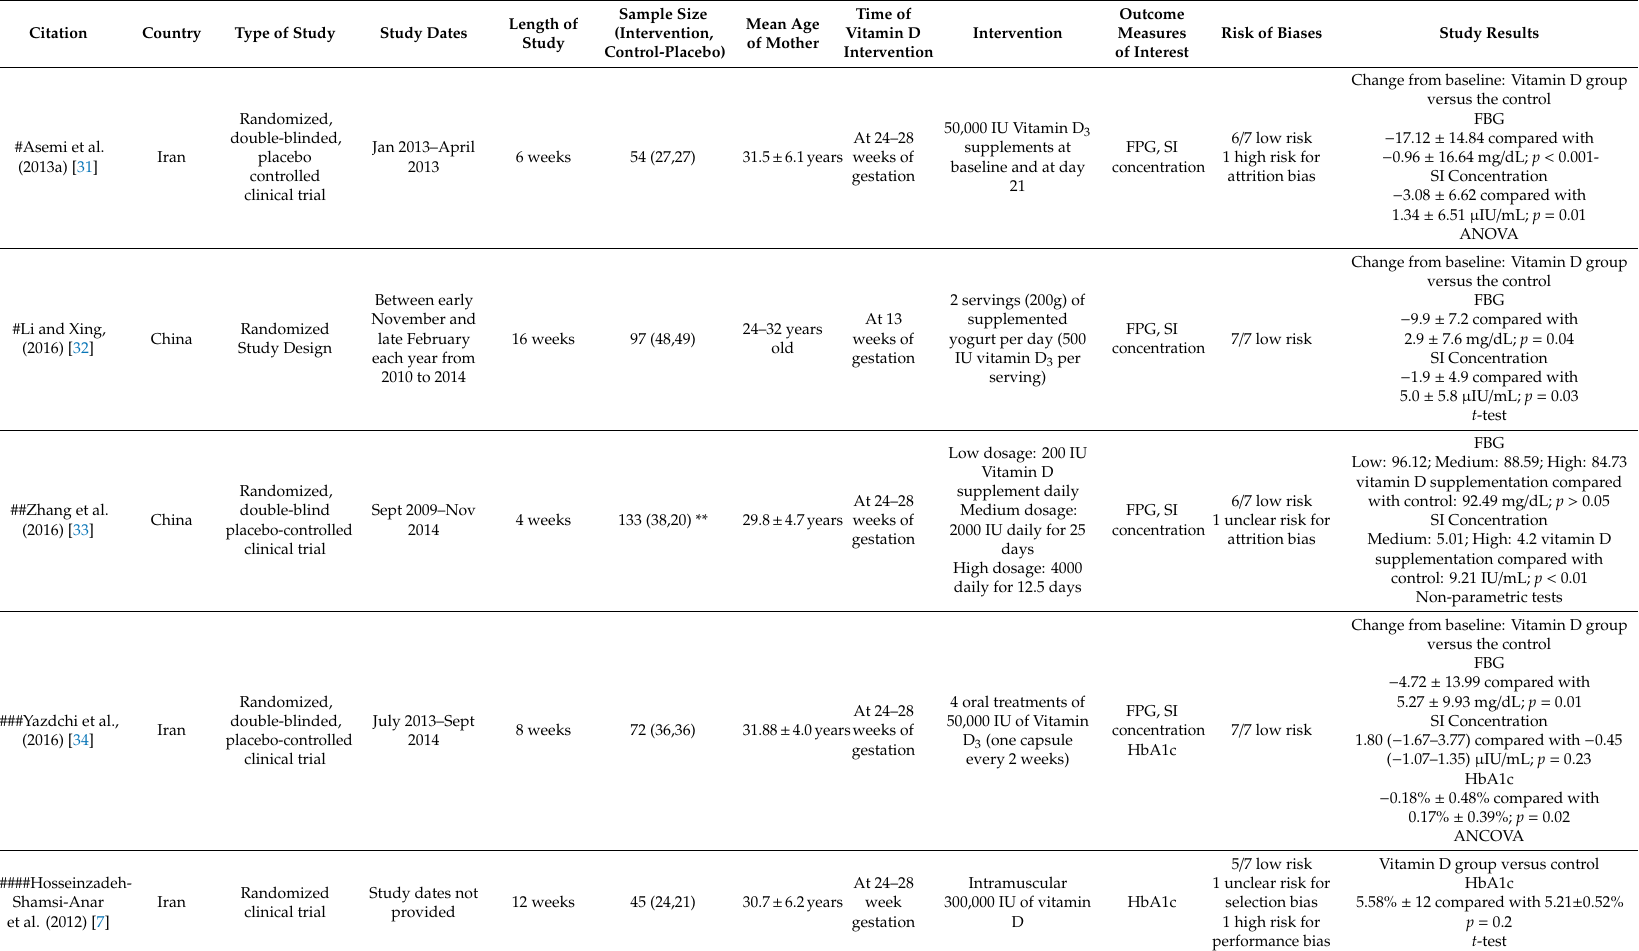
Table 1. Data extraction table for all included